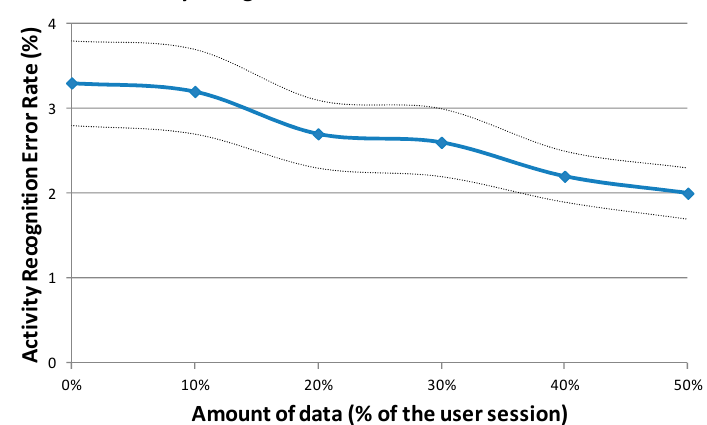
Figure 7. Activity recognition error rate depending on the amount of data for HMMs adaptation (% of the user session).